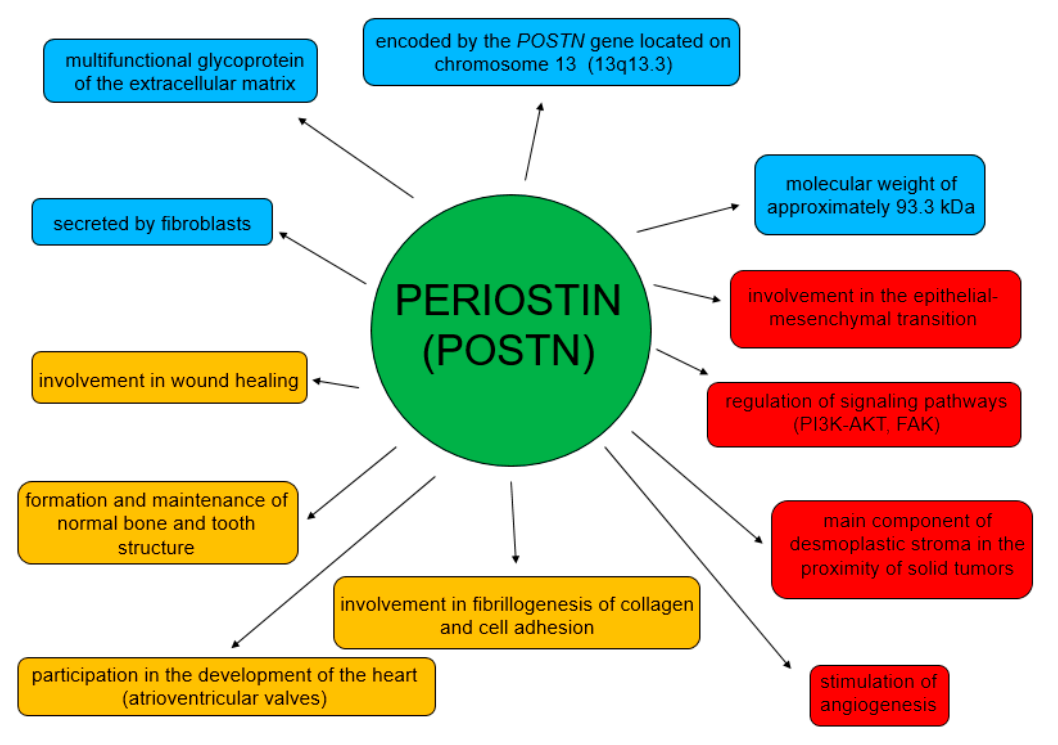
Figure 3. Physiological and pathological roles of POSTN.